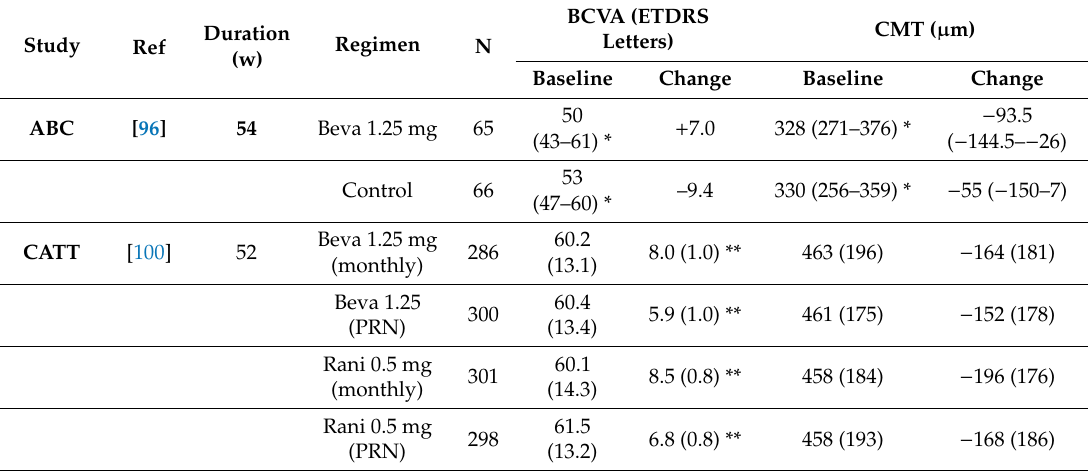
Table 2. Overview of the functional and anatomic results of the main studies evaluating the e ff ect of vascular endothelial growth factor inhibitors (anti-VEGF) in patients with neovascular age related macular degeneration